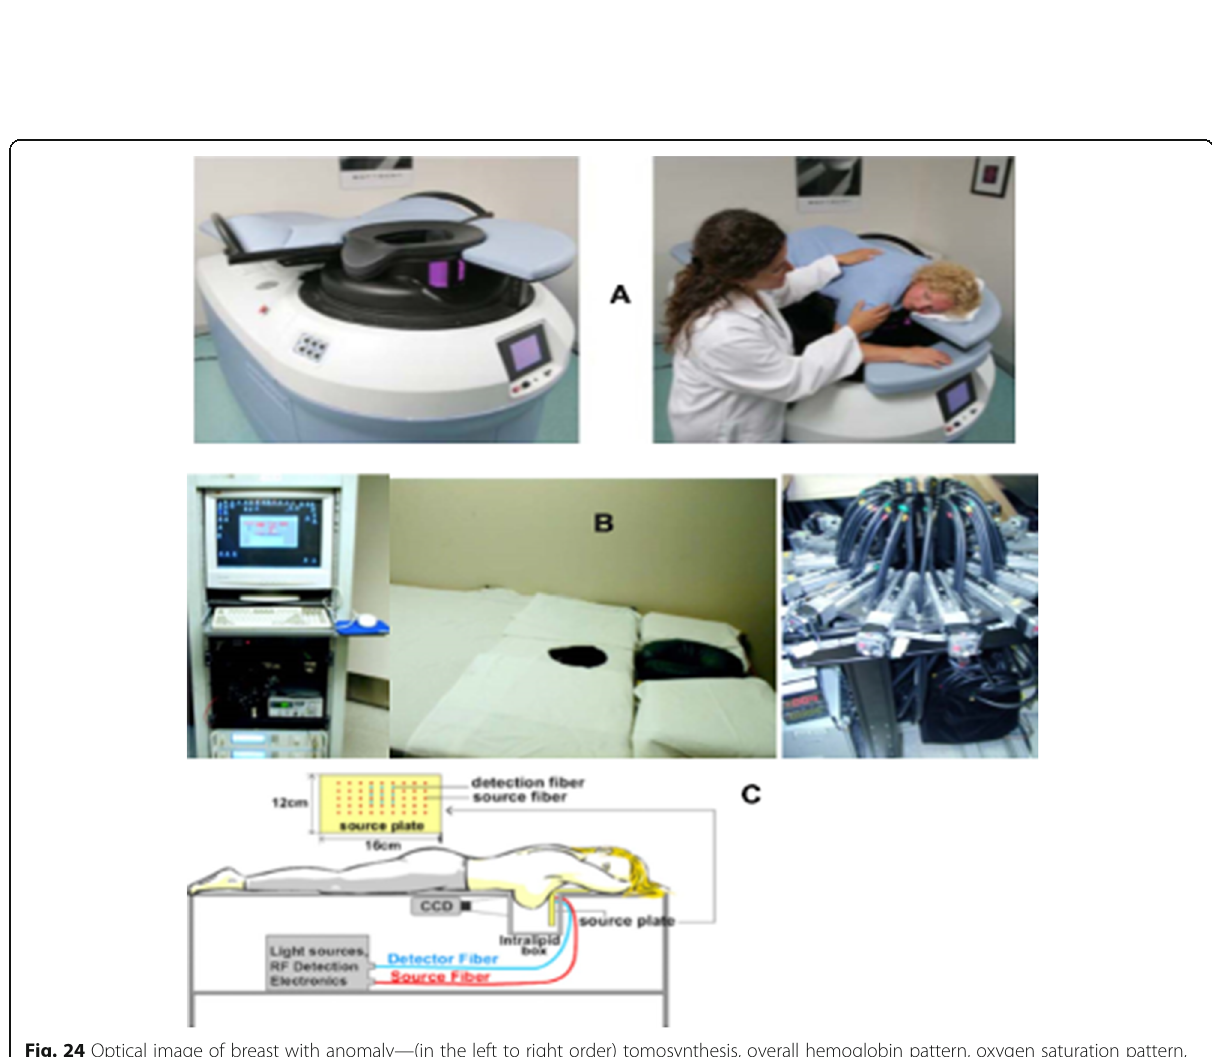
Fig. 24 Optical image of breast with anomaly — (in the left to right order) tomosynthesis, overall hemoglobin pattern, oxygen saturation pattern, and scatter pattern image. Authorization was acquired to display Qianqian Fang ’ s image